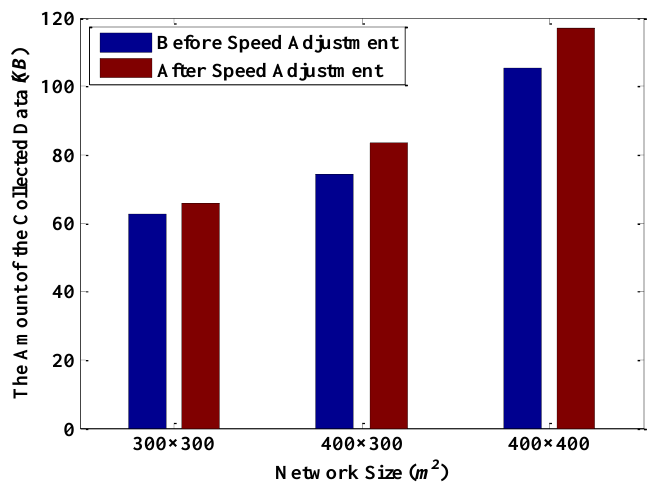
Figure 19. The amount of date collected before and after speed adjustment under different network sizes.